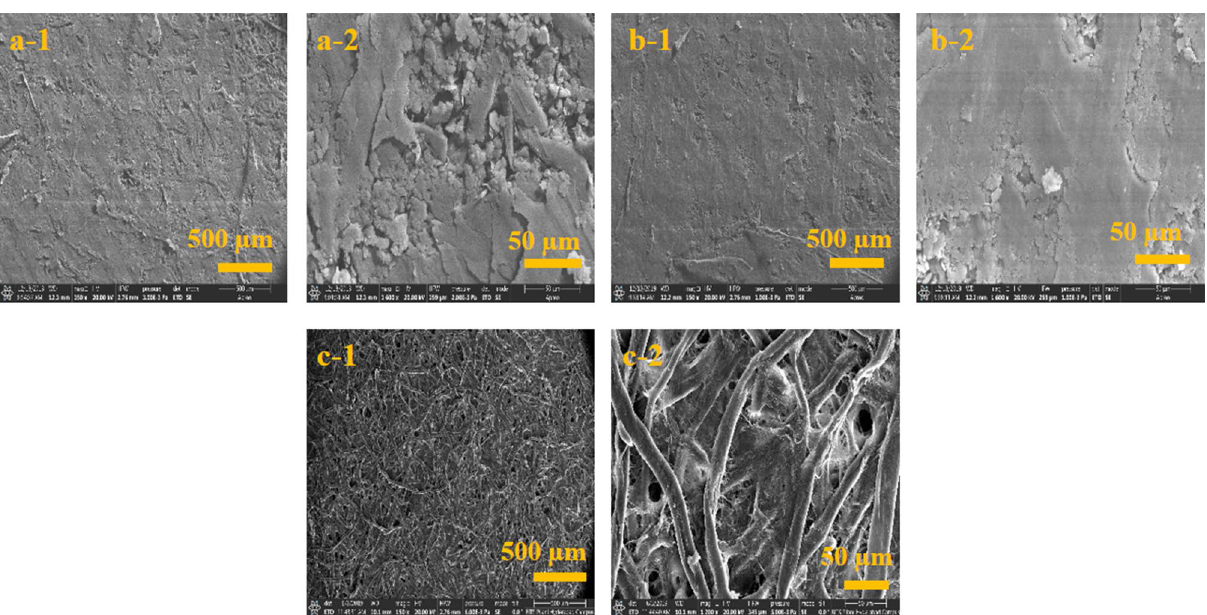
Figure 3. SEM images of automated and manual graphite pencil strokes on Whatman filter paper at 50 strokes, ( a ) automated pencil strokes at different scale bars (500, 50 µm), ( b ) manual pencil strokes at different scale bars (500, 50 µm), and ( c ) Whatman filter paper (microchannel) at different scale bars (500, 50